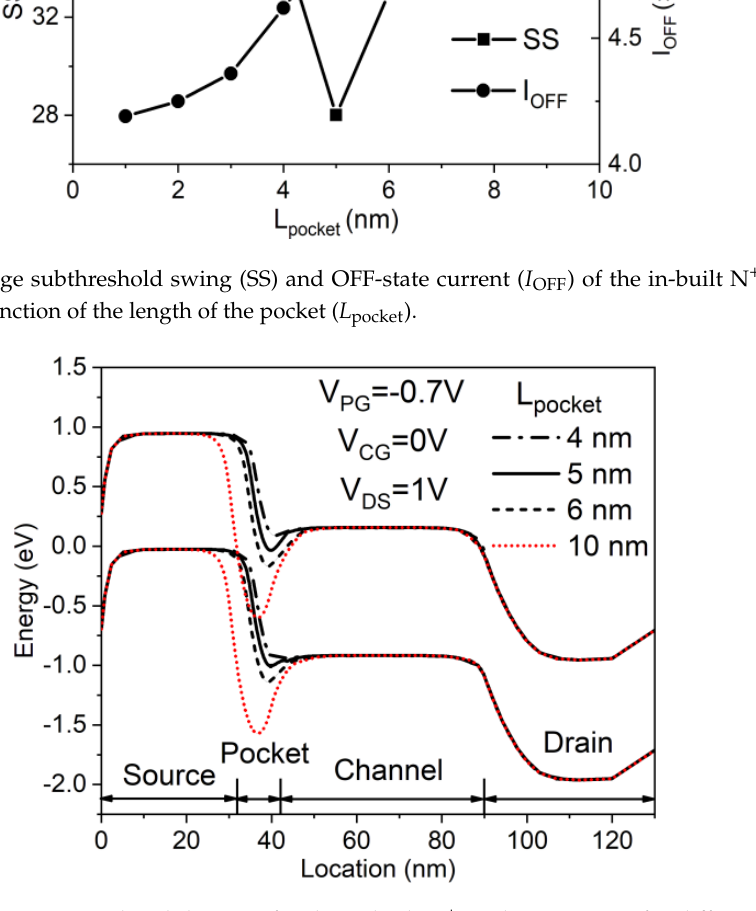
Figure 5. OFF -state energy band diagram for the in-built N + pocket ED-TFET for different pocket lengths ( L pocket ).